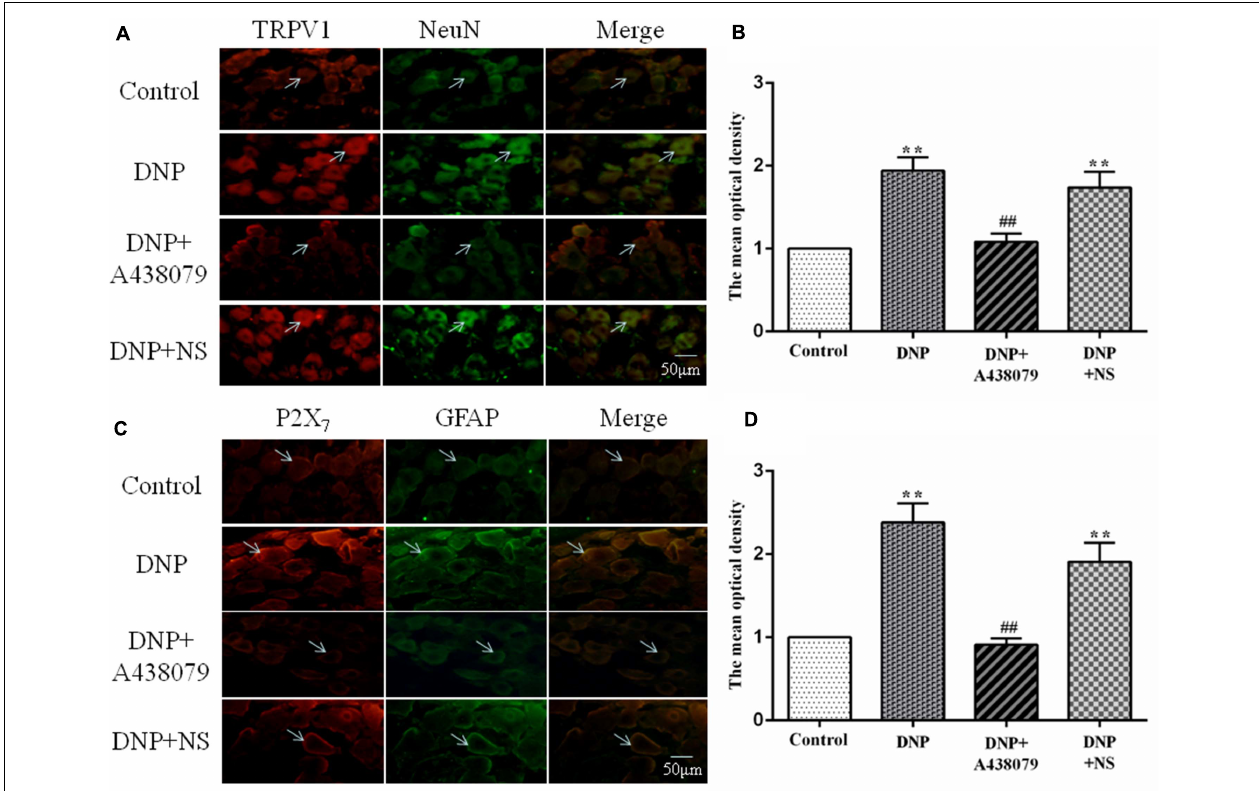
FIGURE 3 | The coexpression of TRPV1 with NeuN and P2X 7 receptor with GFAP was detected by immunofluorescence staining. (A) Levels of TRPV1 with NeuN coexpression in neurons in the rat DRG ( n = 6 rats for each group). (B) The histogram shows the mean optical density of the coexpression of TRPV1 with NeuN. (C) Levels of P2X 7 with GFAP coexpression in SGCs in the rat DRG ( n = 6 rats for each group). (D) The histogram shows the mean optical density of the coexpression of the P2X 7 receptor with GFAP. In the DNP group, the coexpression of TRPV1 with NeuN in the DRG was increased compared with that in the control group, while the coexpression of TRPV1 with NeuN in the DNP + A438079 group was decreased compared with that in the DNP group. Furthermore, the coexpression of P2X 7 receptor with GFAP in the DRG was consistent with the coexpression trend described above. The green signal is fluorescein isothiocyanate (FITC)-labeled NeuN and FITC-labeled GFAP; the red signal is tetramethylrhodamine isothiocyanate (TRITC)-labeled TRPV1 and TRITC-labeled P2X 7 ; and the yellow signal is the combination of the green and red signals. The arrow indicates activated neuronal cells and SGCs in the DRG. The scale bar represents 50 µ m. The data are presented as the mean ± SEM; compared with the control group, ** P < 0.01; compared with the DNP group, ## P < 0.01.